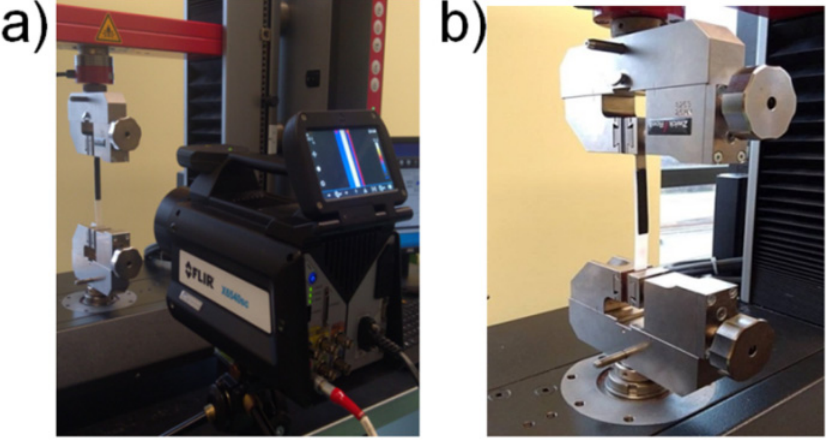
Figure 3. IR camera position versus sample face mounted in ( a ) clamping units; ( b ) mounted sample, black surface indicates polymer part in lap-joint sample.